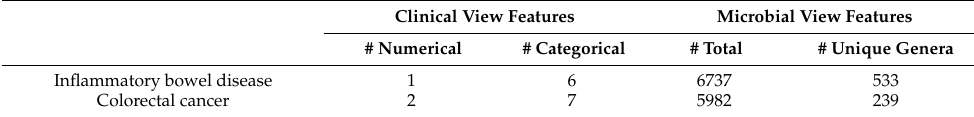
Table 1. Dataset characteristics for inflammatory bowel disease and colorectal